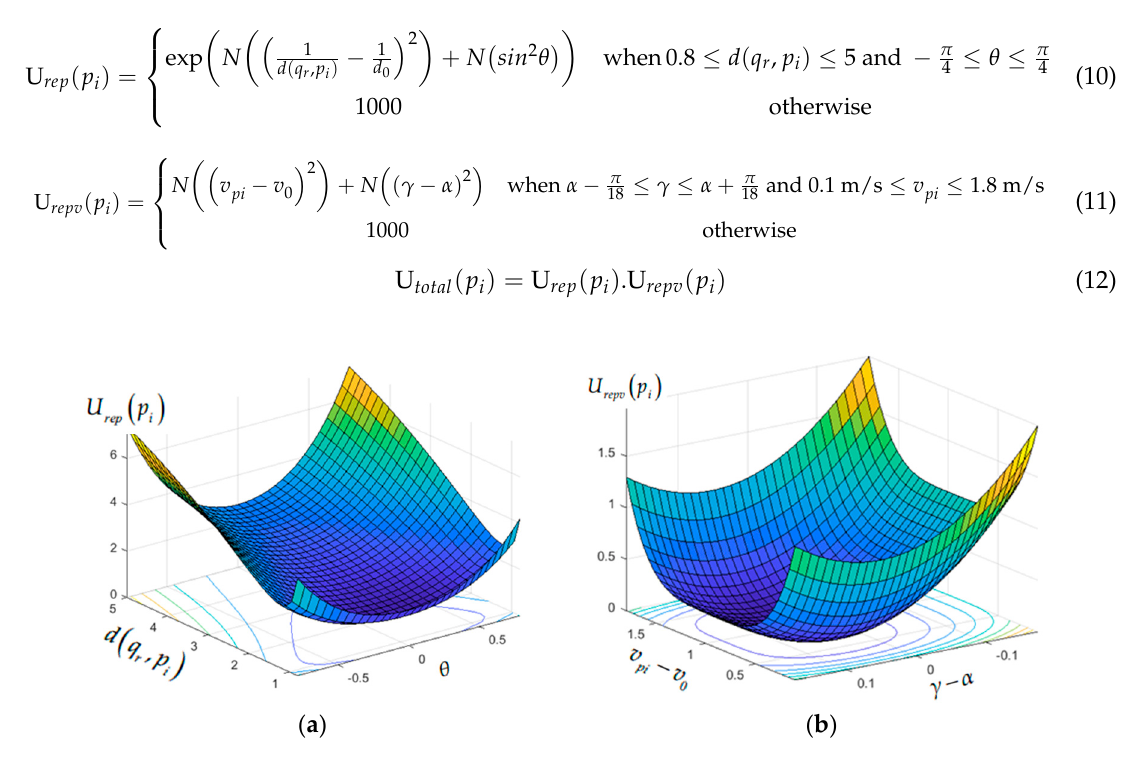
Figure 5. ( a ) The variation of function, U rep ( p i ), with d ( q r , p i ) and θ ; ( b ) the variation of the function, U repv ( p i ), with the walking speed deviation from the ideal walking speed, v pi -v 0 , and the direction deviation from the desired angle, γ - α .